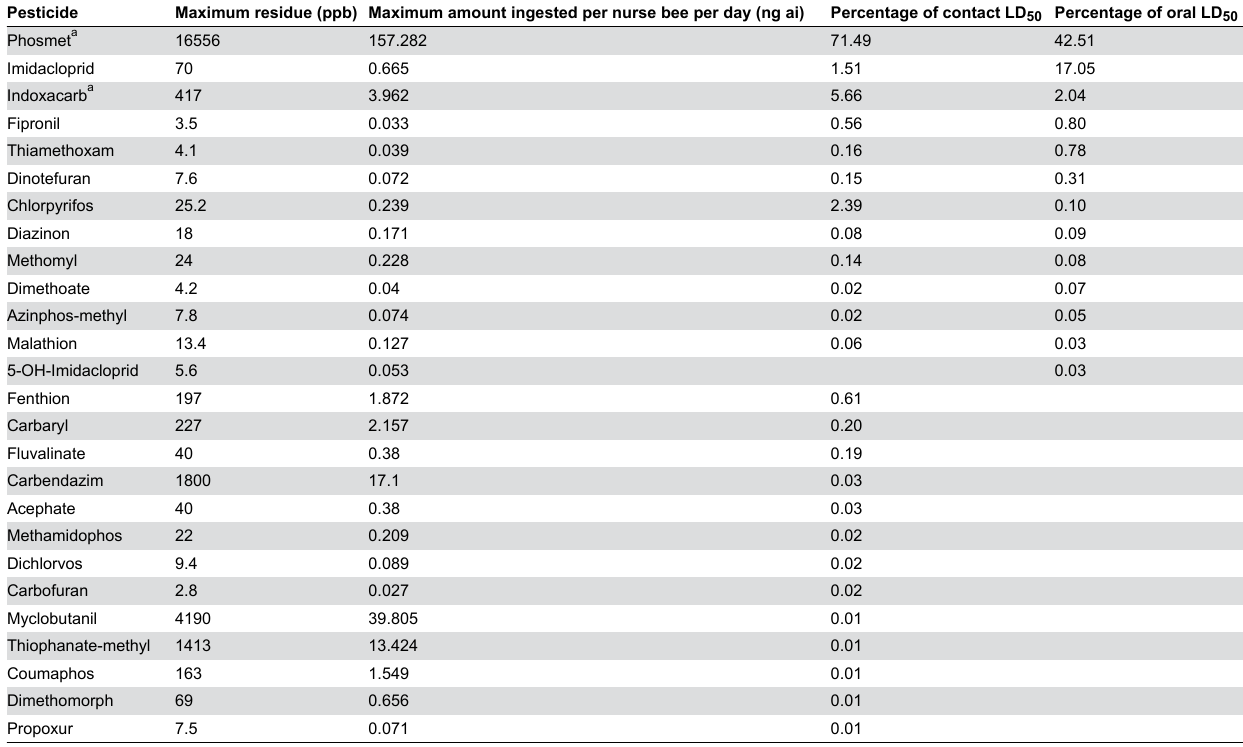
Table 3. Relationship of the maximum residue detected in a sample of trapped pollen to the contact and oral LD adult worker honey bee, based on a consumption of 9.5 mg of pollen per bee per day (for nurse bees,